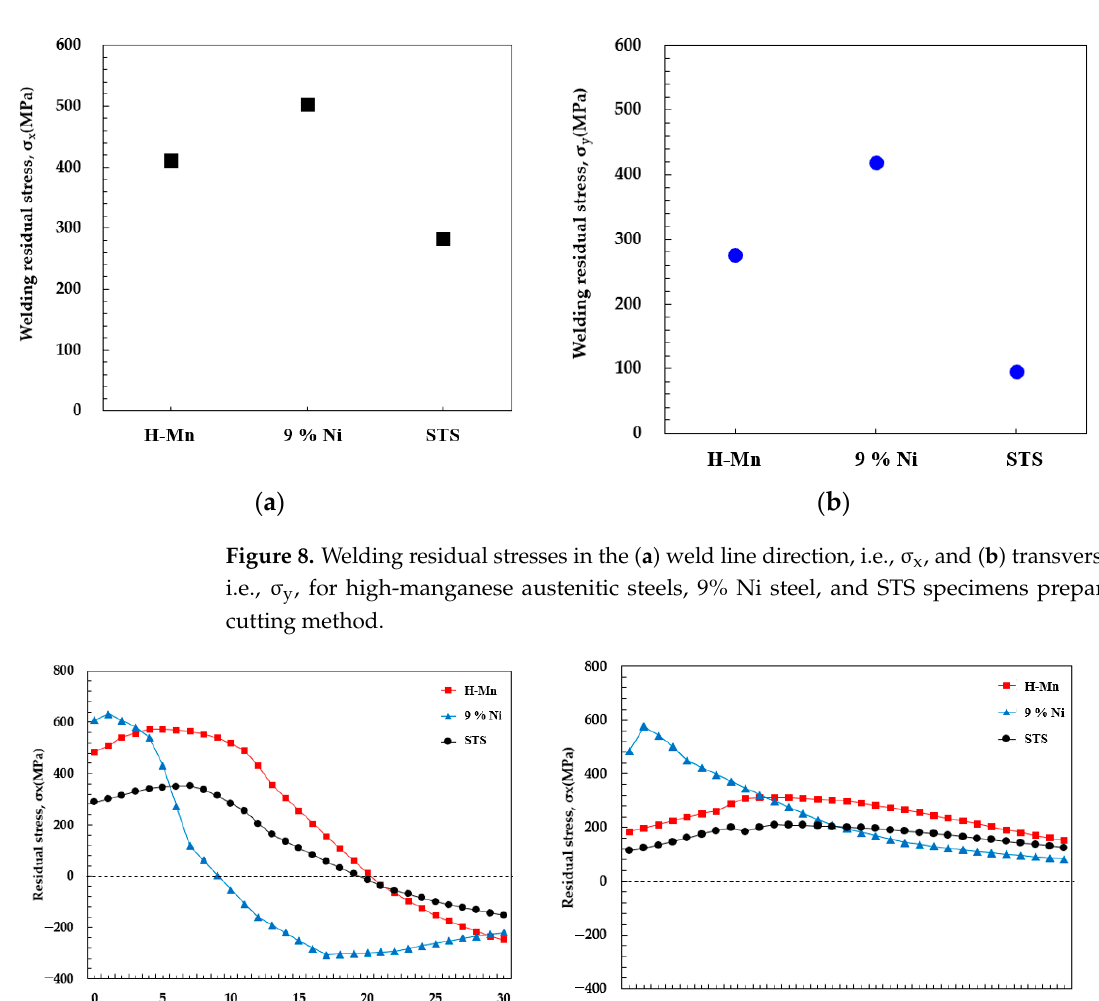
Figure 8. Welding residual stresses in the ( a ) weld line direction, i.e., σ x , and ( b ) transverse direction,